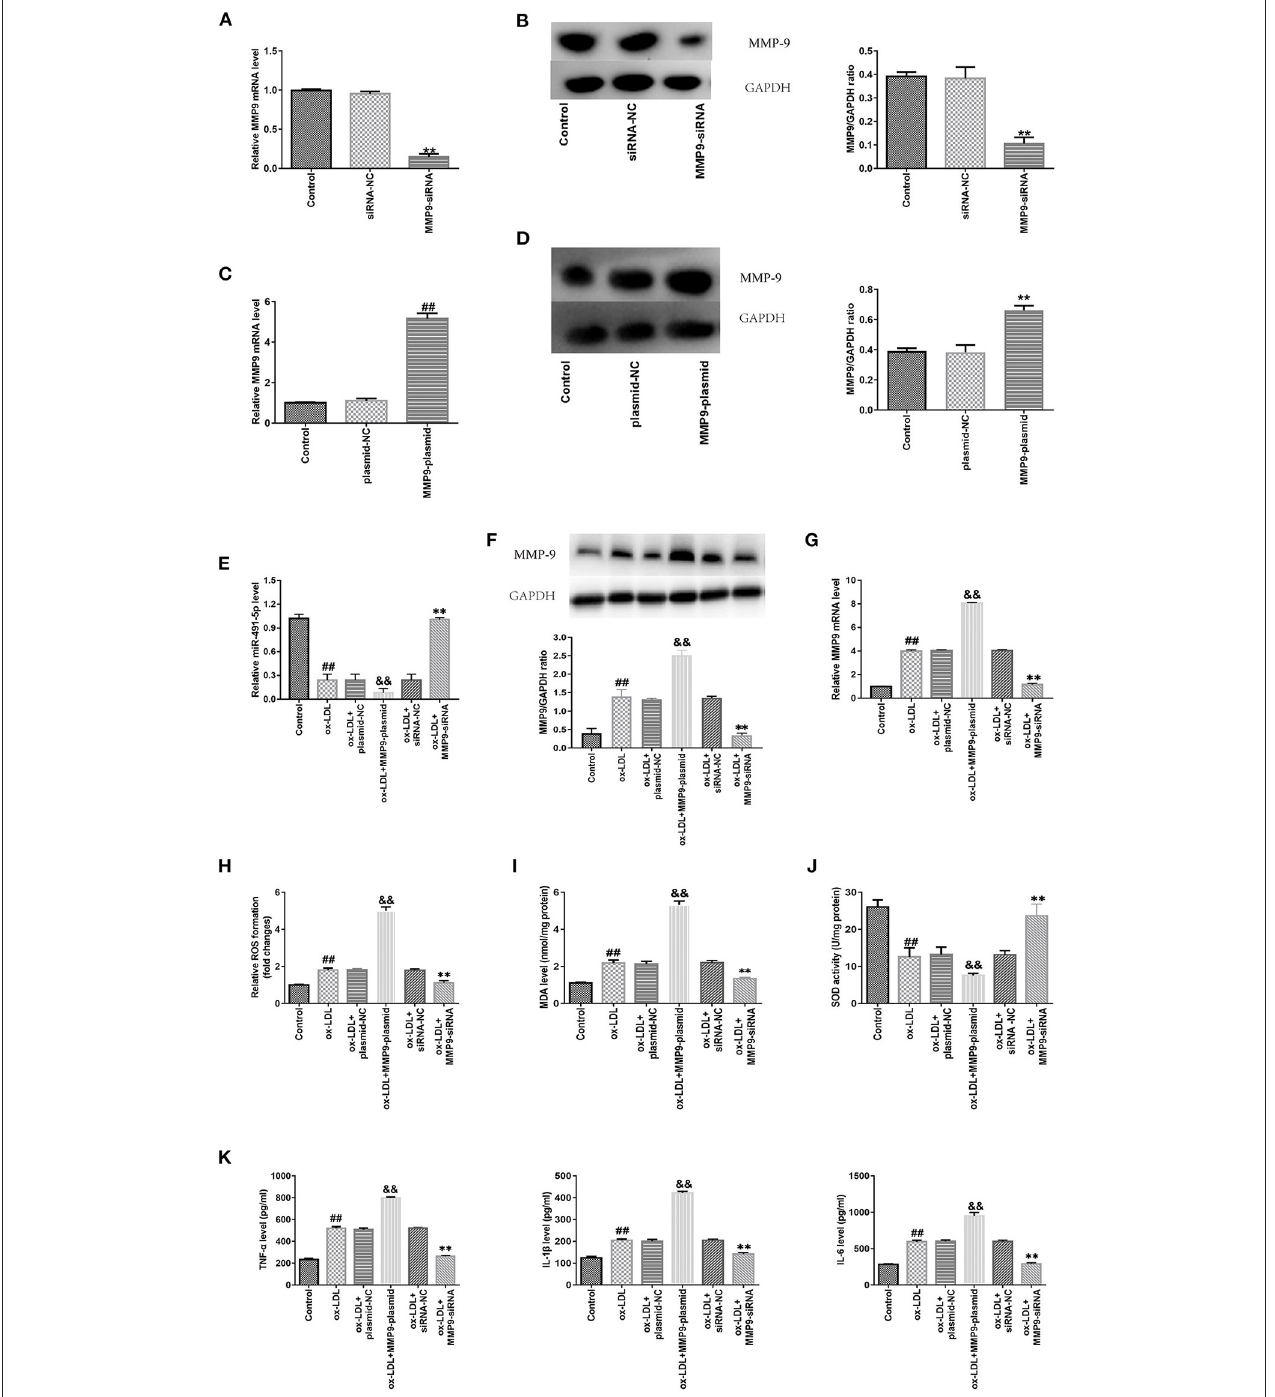
FIGURE 3 | Effect of MMP-9 on the oxidative stress and inflammatory reactions in ox-LDL-induced THP-1 macrophages. (A–D) THP-1 macrophages were introduced with MMP-9-siRNA and MMP-9-plasmid. Transfection efficiency of MMP-9-plasmids and MMP-9-siRNA were measured with qRT-PCR, whereas MMP-9 protein was measured with western blotting. (E–K) Transfected THP-1 macrophages were stimulated with 50 µ g/mL ox-LDL. (E) MiR-491-5P expression of transfected THP-1 macrophages was determined with qRT-PCR. (F,G) MMP-9 protein and mRNA expression of transfected THP-1 macrophages was determined by western blotting and qRT-PCR, respectively. (H–J) ROS and MDA levels and SOD activity were measured using commercial kits. (K) Levels of inflammatory factors (TNF- α , IL-1 β , and IL-6) were detected using ELISA. Data are presented as the mean ± SD, n = 6. Compared with the control group, ## P < 0.01; compared with the plasmid-NC group, && P < 0.01; compared with the si-RNA-NC group, ** P < 0.01.